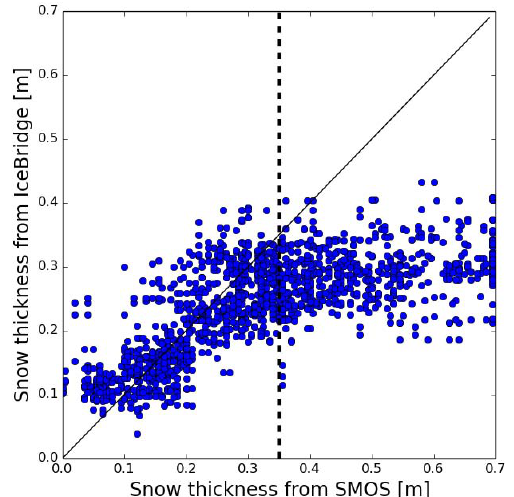
Fig. 9. Snow thicknesses as retrieved from horizontally polarised SMOS brightness temperatures vs. coincident snow thicknesses as measured during the IceBridge campaign. Here, we show the results for the simulation with θ = 15–50 ◦ , T surf = − 38.15 ◦ C, ρ snow = 260kgm − 3 , d ice = 4m, and S ice = 1 . 5gkg − 1 (simulation scenario no. 6). The dashed line indicates the result, if we consider only snow thicknesses for that the retrieval from SMOS brightness tempera- tures gives snow thicknesses d snow < 35cm.